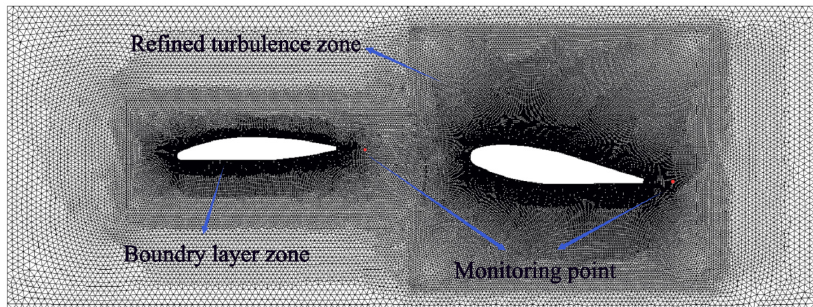
Figure 1. Mesh of the tandem cascade structure.